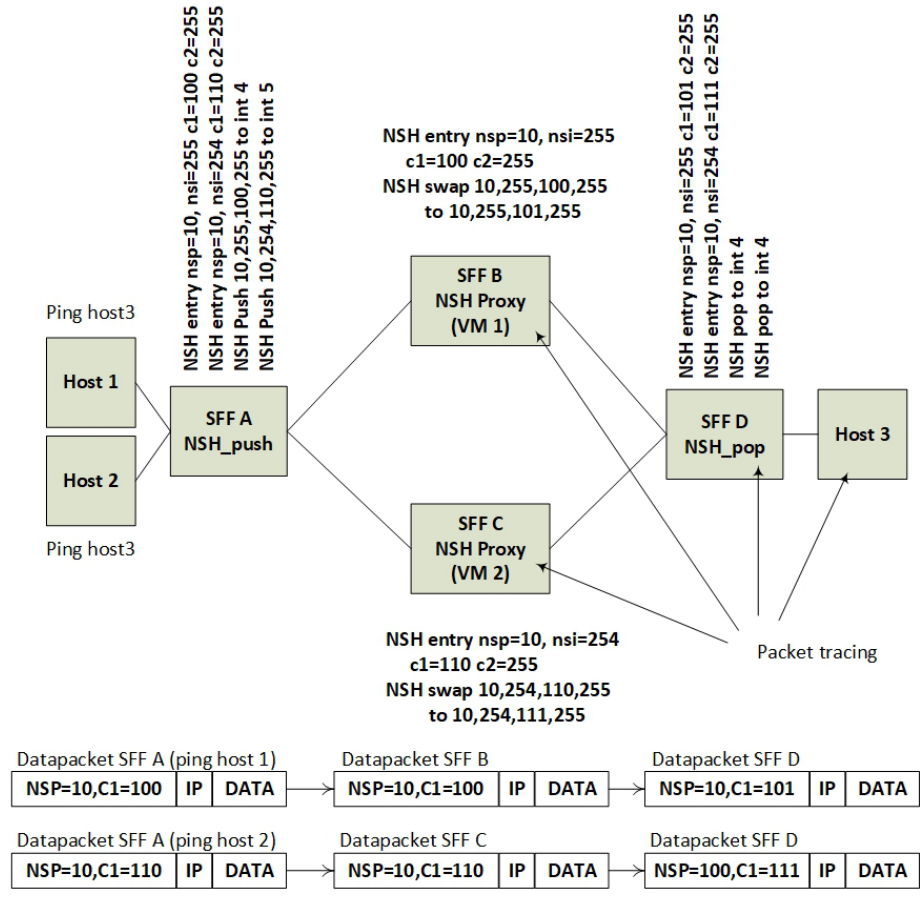
Figure 25. The lab